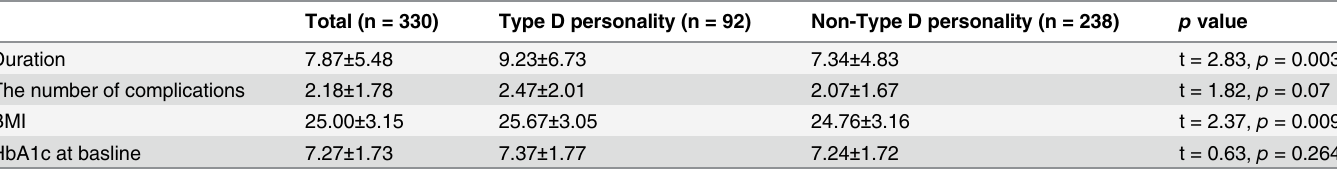
Table 2. The comparison of the clinical outcomes between the patients with or without Type D